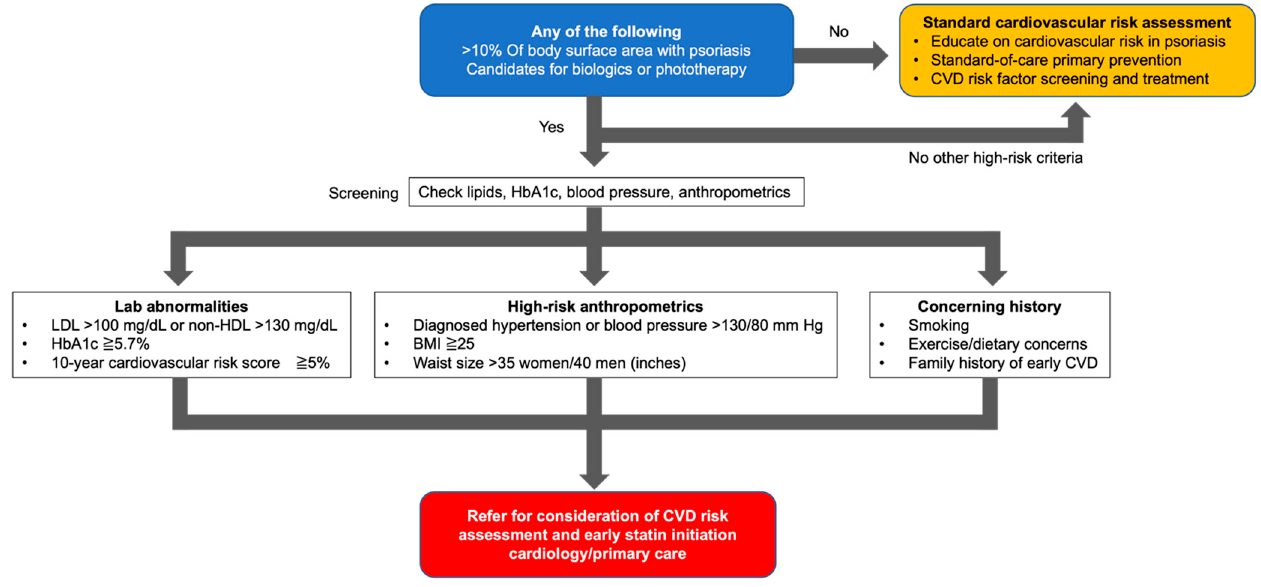
Figure 1. Suggested role of primary clinicians in primary cardiovascular prevention in psoriasis patients. Adapted from Garshick, M.S. and Berger, J.S. JAMA dermatology [84]. BSA: body surface area, CVD: cardiovascular disease, BMI: body mass index.